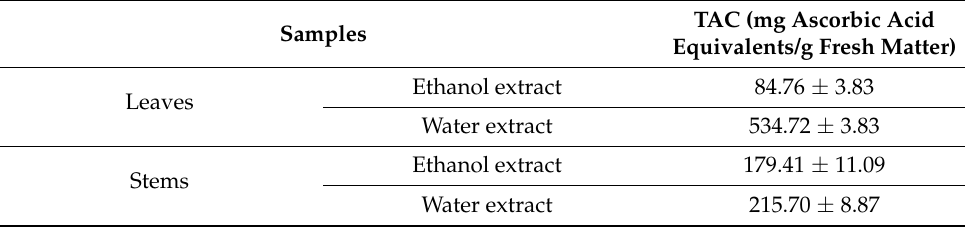
Table 4. Total antioxidant capacity (TAC) of water and ethanol extracts of leaves and